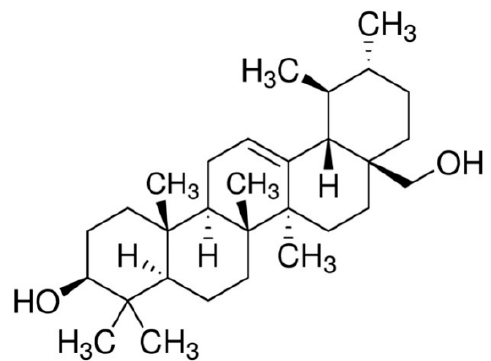
Figure 1. Chemical structure of uvaol.